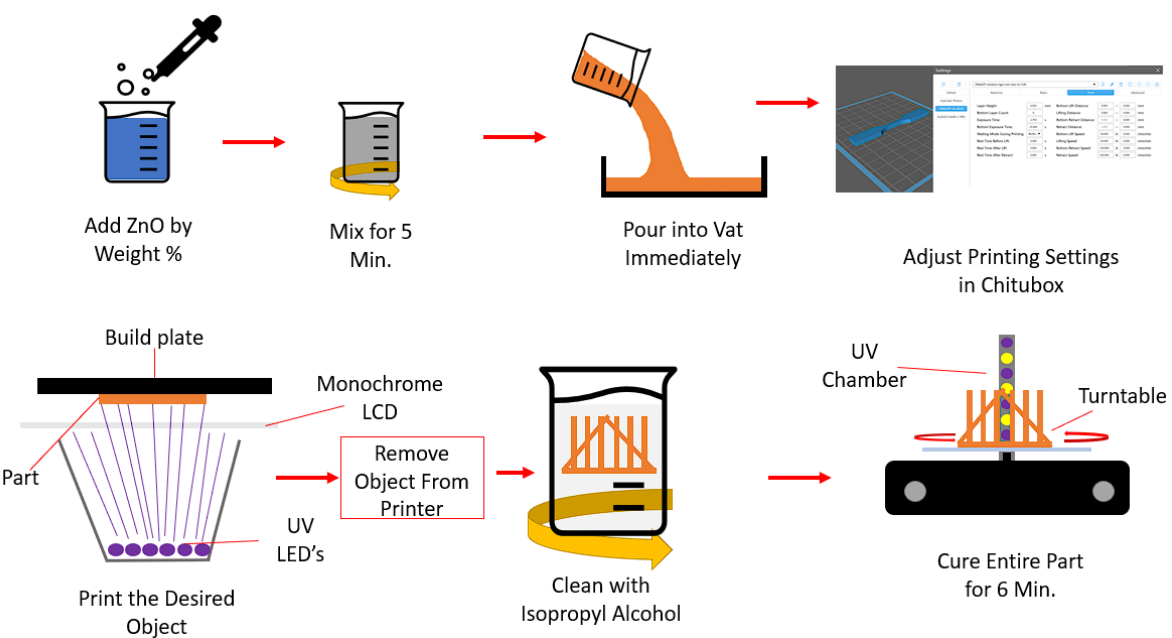
Figure 1. The manufacturing process for ZnO nanocomposite resin.